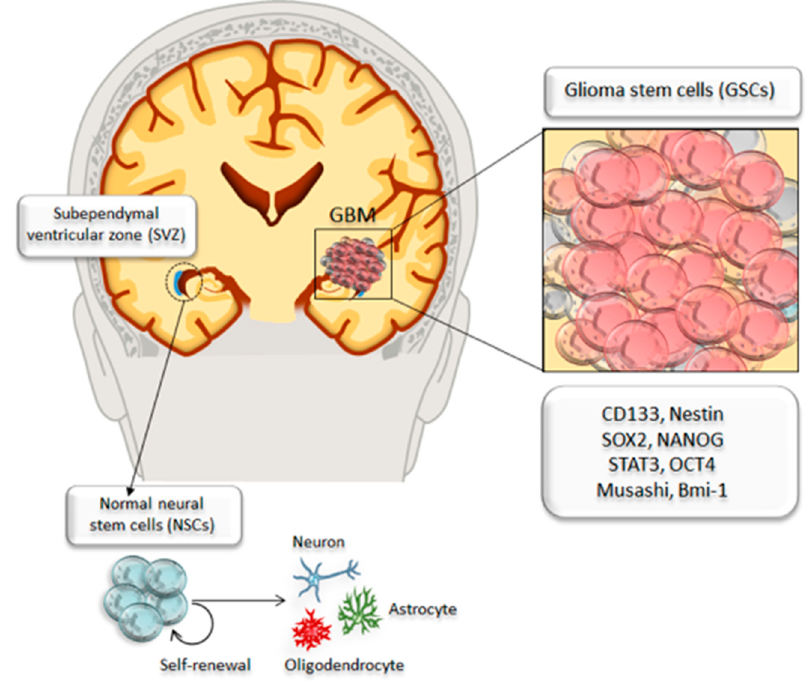
Figure 1. Identifying cancer stem cells in glioblastoma. Neural stem cells (NSCs) reside within the subependymal ventricular zone (SVZ), which represents the classic neurogenic niche of the adult brain. Within the SVZ, NSCs can undergo self-renewal or they can differentiate into neurons, astrocytes, and oligodendrocytes. The development of glioblastoma multiforme (GBM) depends on a small population of tumor cells known as glioma stem cells (GSCs). GSCs share several core properties of NSCs, such as stemness and sustained proliferation. GSCs that harbor tumor-initiating potential can be identified through specific markers such as CD133, Nestin, SOX2, NANOG, STAT3, Musashi, Bmi-1.